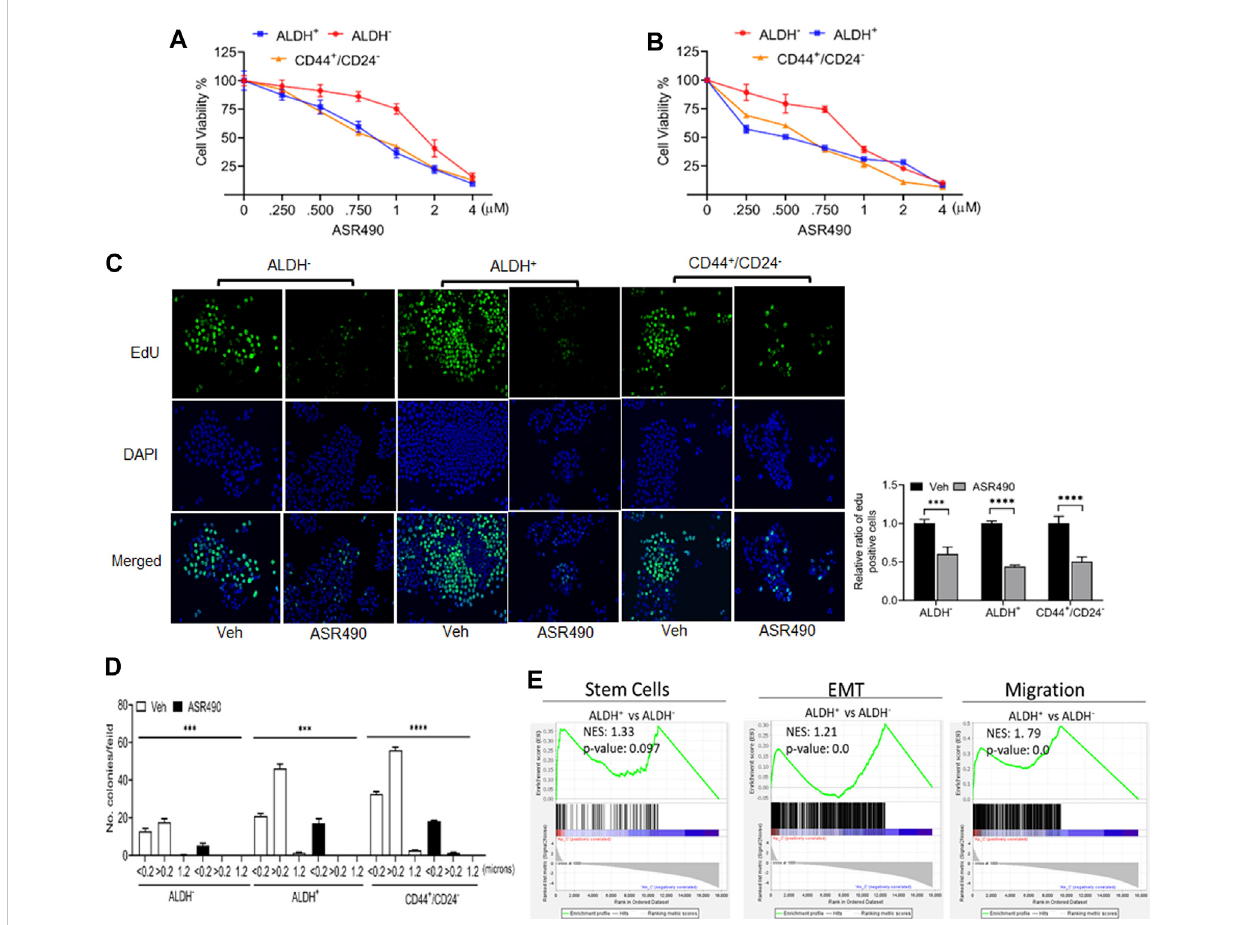
FIGURE 1 ASR490 suppresses the growth of ALDH − , ALDH + , and CD44 + /CD24 − (A, B) . MTT cell viability assays performed on ALDH − , ALDH + , and CD44 + / CD24 − cells following treatment with various concentrations of ASR490 (0, 0.250, 0.500, 0.750, 1, 2, and 4 µM) for 24 (A) and 48 h (B) ( n = 6). (C) Representative images of EdU cell proliferation assay performed on vehicle and ASR490-treated ALDH − , ALDH + , and CD44 + /CD24 − cells. Data were quanti fi ed by counting the cells demonstrating EdU (5-ethynyl-2 ′ -deoxyuridine) expression per treatment group for each cell type using Image J software ( n = 4, *** p < 0.001 and **** p < 0.0001). p values are based on two-way ANOVA with the post hoc Sidak test. (D) Colony-forming assay of the vehicle and ASR490-treated ALDH − , ALDH + , and CD44 + /CD24 − cells ( n = 6; *** p < 0.006 and **** p < 0.0001). p values are based on one-way